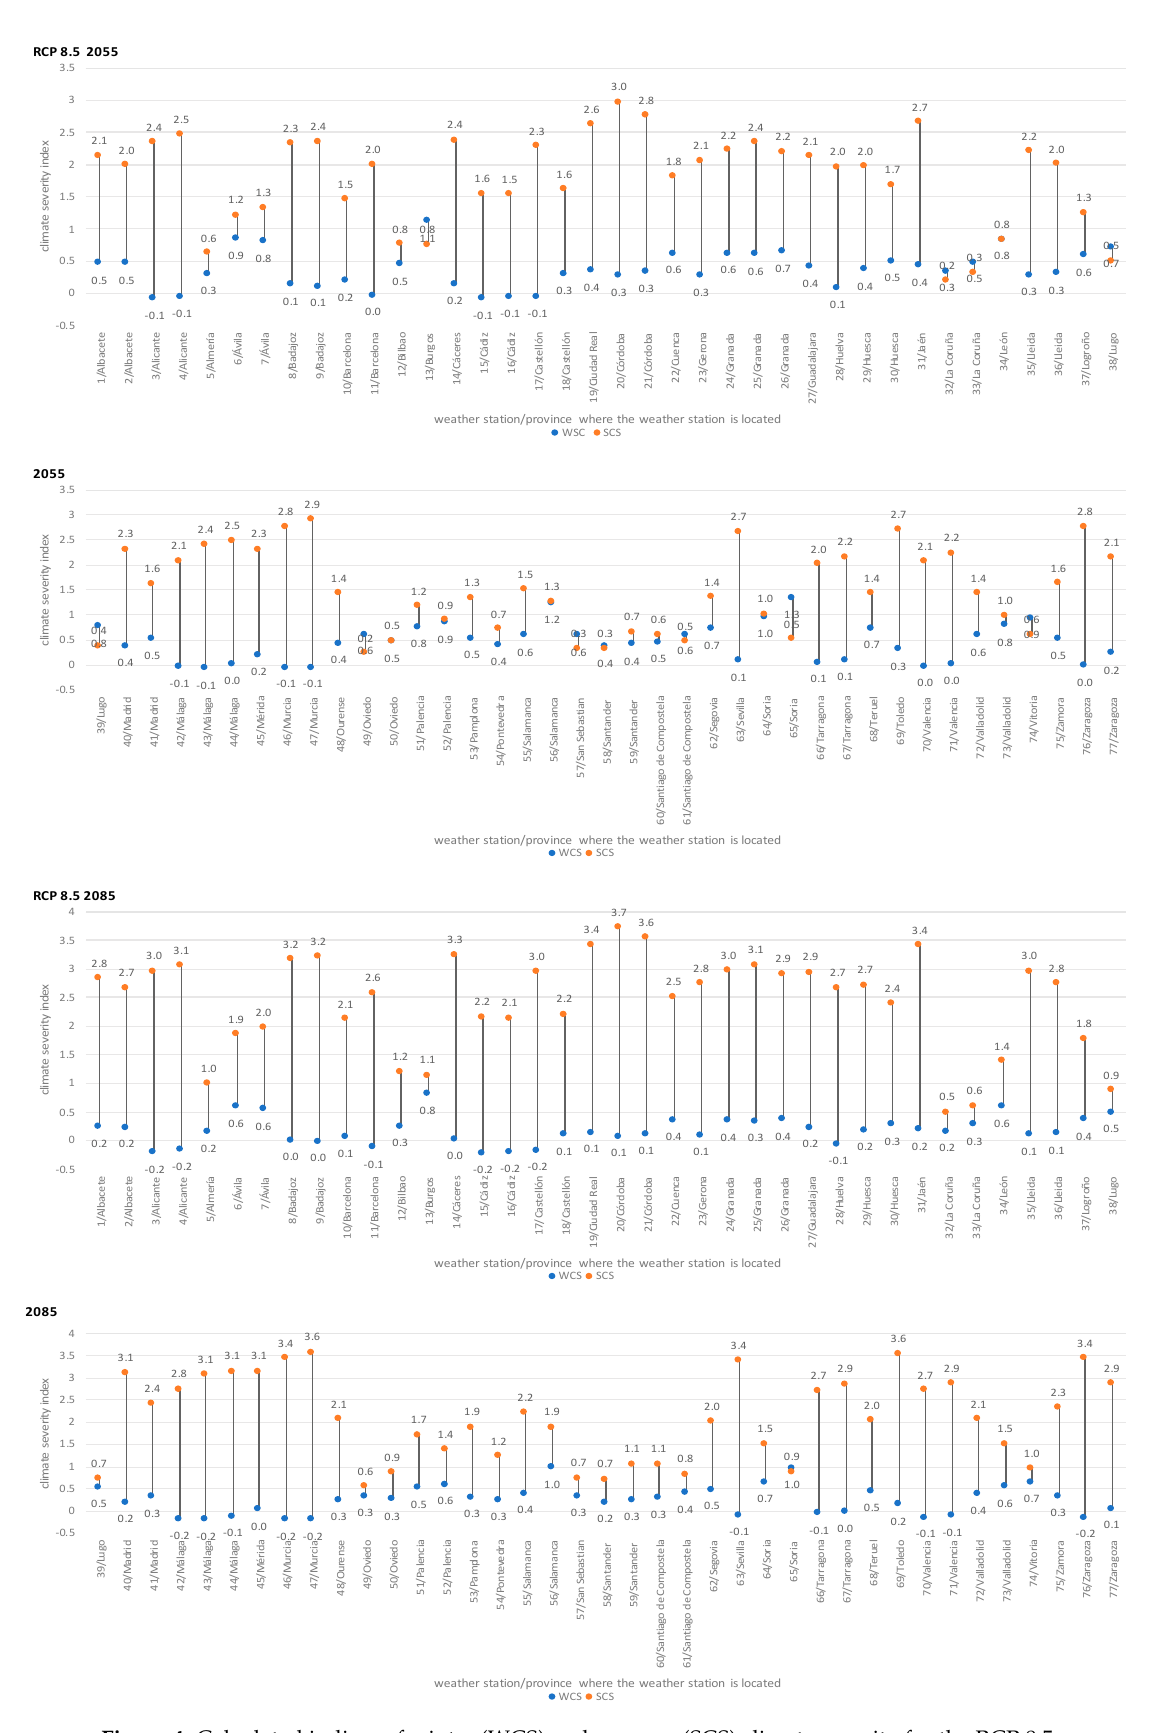
Figure 4. Calculated indices of winter (WCS) and summer (SCS) climate severity for the RCP 8.5.